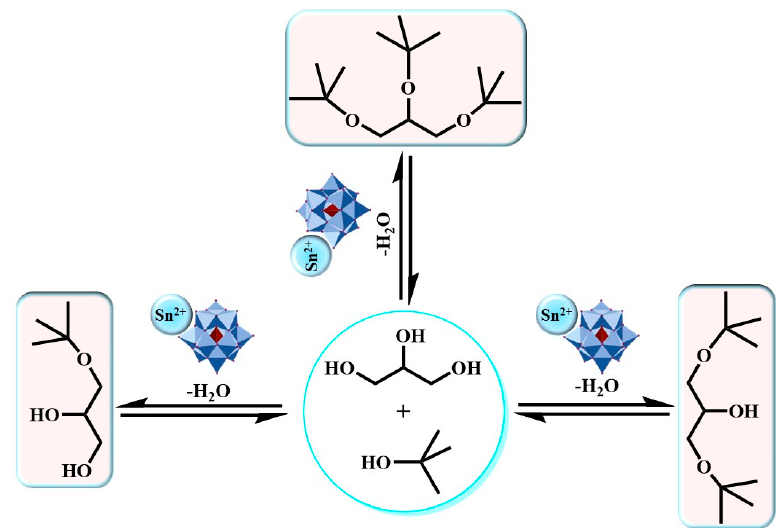
Figure 21. Main tert − butyl glycerol ethers obtained in the Sn(II) heteropoly salts